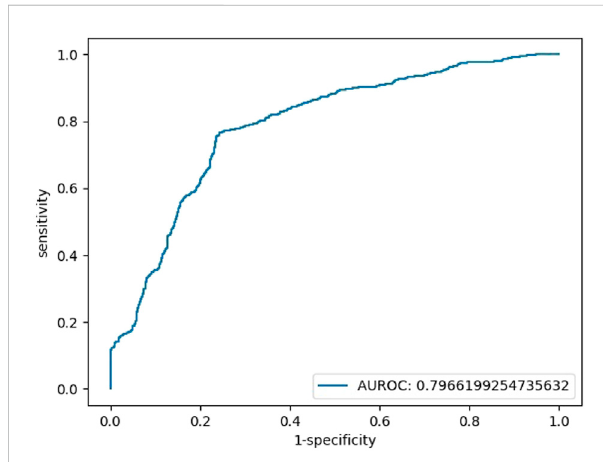
FIGURE 2 Testing set ROC curve of the early diagnosis of schizophrenia with the features of glucose, TBIL, and